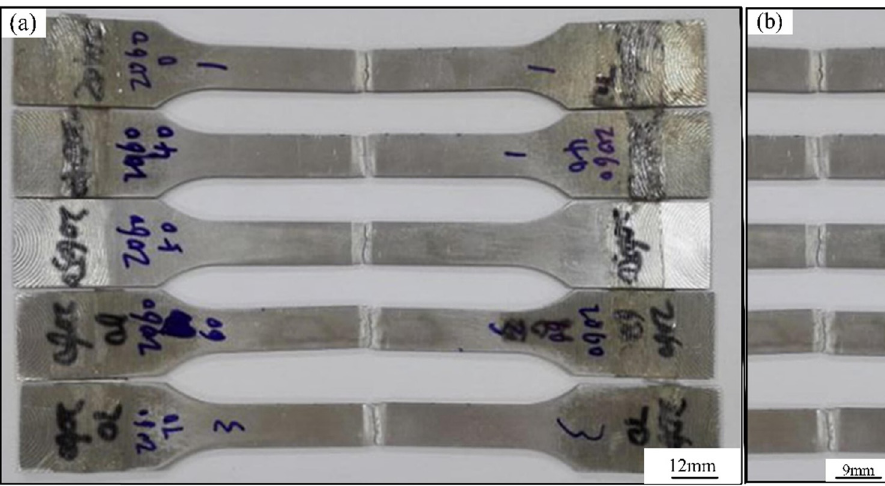
Figure 13: Samples after fracture: ( a ) tensile samples and ( b ) magnified view of